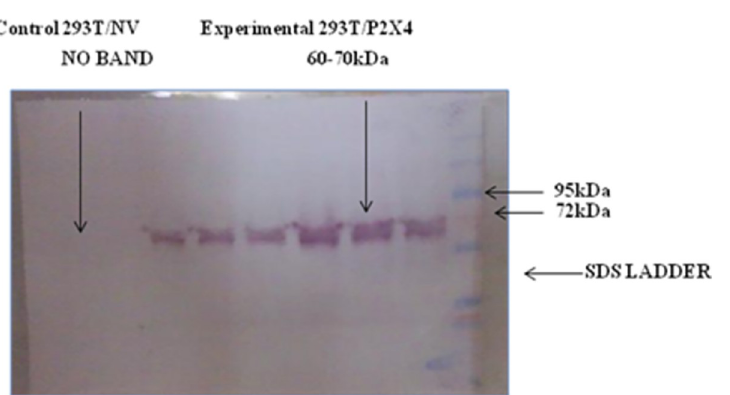
Fig 9. Protein expression analysis of P2X4 receptor. Western blot of P2X4 receptor (Protein lysate of selected single clones of cell lines 293T/P2X4 and 293T/NV). The predicted molecular mass of P2X4 is ~ 46kDa, but it is generally detected near 60–70 kDa because of glycosylation.